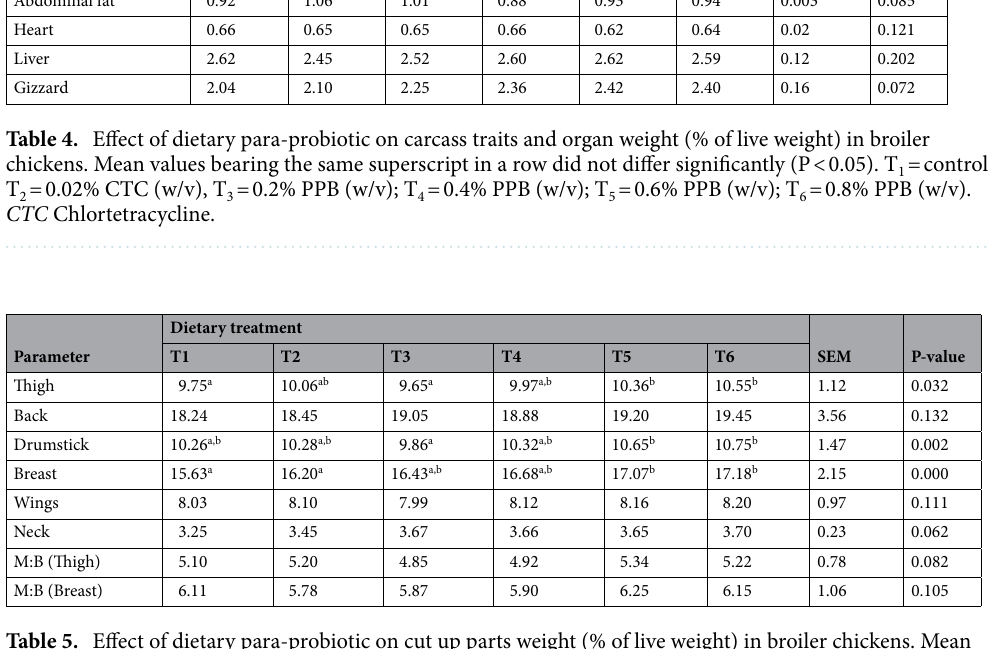
Table 5. Effect of dietary para-probiotic on cut up parts weight (% of live weight) in broiler chickens. Mean values bearing the same superscript in a row did not differ significantly (P < 0.05). T 1 = control, T 2 = 0.02% CTC (w/v), T 3 = 0.2% PPB (w/v); T 4 = 0.4% PPB (w/v); T 5 = 0.6% PPB (w/v); T 6 = 0.8% PPB (w/v). CTC Chlortetracycline, M:B Meat bone ratio.